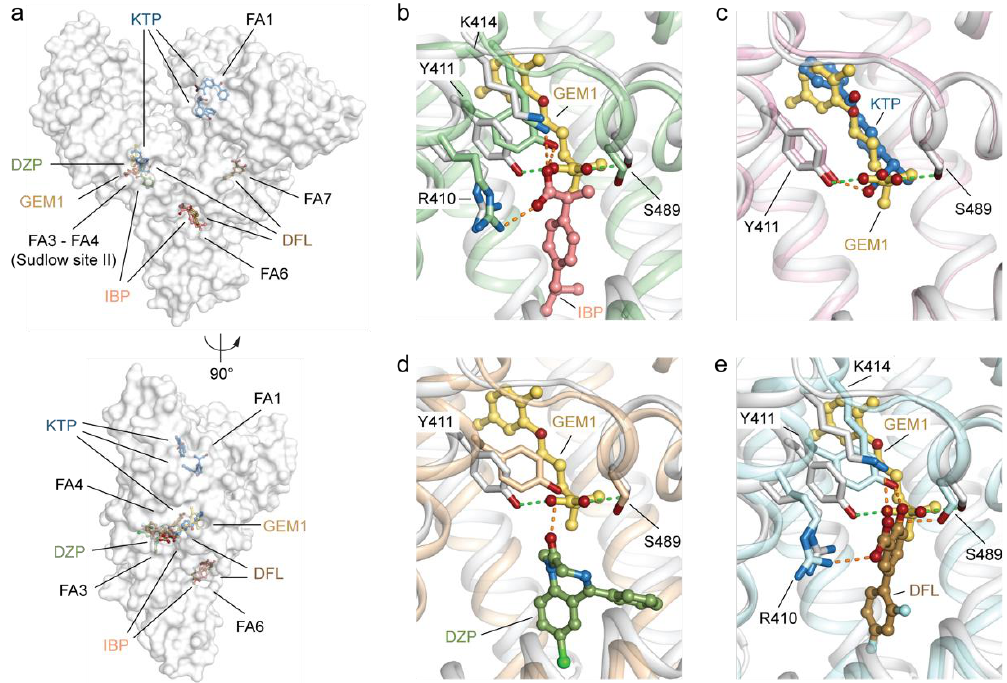
Figure 4. Structural comparison of the ligand binding mode of GEM1 with that of other known drugs binding HSA Sudlow ’ s site II (FA3-FA4) in sub-domain IIIA. ( a ) Molecular surface representation of the overall HSA-GEM complex (white; PDB identification code: 7QFE) aligned with HSA-ibuprofen (IBP; PDB identification code: 2BXG), HSA-ketoprofen (KTP; PDB identification code: 7JWN), HSA-diazepam (DZP; PDB identification code: 2BXF), and HSA-diflunisal (DFL; PDB identification code: 2BXE) complexes. The superimposed complexes are shown in two orien- tations (90° rotation). Detailed view of the superimposed GEM1 (yellow orange) to ( b ) IBP (salmon), ( c ) KTP (sky blue), ( d ) DZP (smudge), and ( e ) DFL (brown) molecules bound to Sudlow ’ s site II (FA4). The α -helices of HSA in complex with GEM1, IBP, KTP, DZP, and DFL are represented by cartoon loops and coloured in white, pale green, light pink, wheat, and pale cyan, respectively. The selected labelled amino acid side chains are represented as sticks and coloured by atom type (carbon = white for the HSA-GEM1 complex, pale green for the HSA-IBP complex, light pink for the HSA-KTP complex, wheat for the HSA-DZP complex, pale cyan for the HSA-DFL complex, firebrick for oxygen, and sky blue for nitrogen). Bound ligands are shown in a ball-and-stick representation and coloured by atom type (GEM1: carbon = yellow orange and oxygen = firebrick; IBP: carbon = salmon and oxygen = firebrick; KTP: carbon = sky blue, oxygen = firebrick, and nitrogen = sky blue; DZP: carbon = smudge, oxygen = firebrick, nitrogen = sky blue, and chlorine = light green; and DFL: carbon = brown, oxygen = firebrick, and fluorine = pale cyan). For visualisation, only the side chains of amino acids of HSA forming inter-molecular polar interactions below 4.0 Å are shown. Inter-molecular interactions are represented as dashed lines. Those established by GEM1 are coloured in light green, while those formed by IBP, KTP, DZP, and DFL are coloured in orange. The three-dimensional structure models were generated and rendered using Pymol [29].